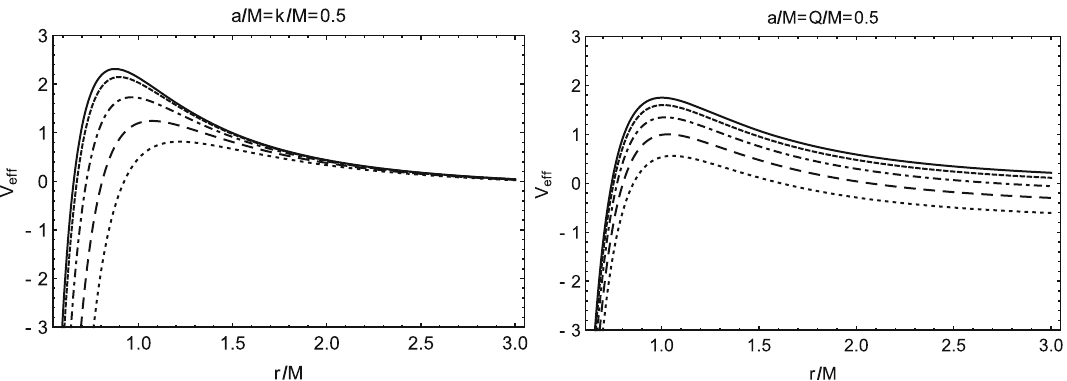
Fig. 2 Radial potential for photons with fixed parameters E = 0 . 9 and L = 4. In the left panel the values ascribed to Q (top to bottom) are 0, 0.2, 0.4, 0.6 and 0.8 and in the right panel n (top to bottom) has the values 0.2, 0.4, 0.6, 0.8 and 1